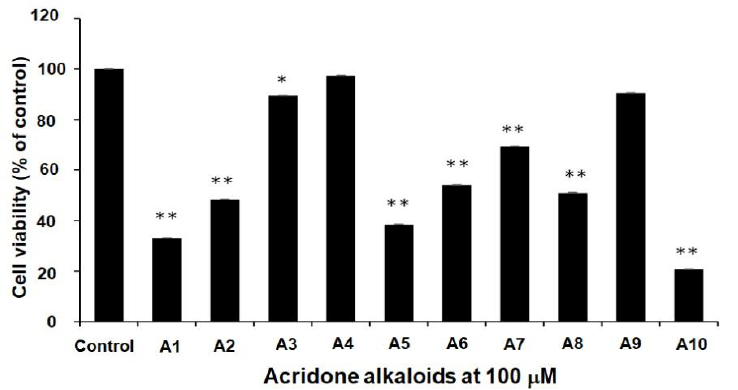
Figure 2. The cytotoxicity effect of acridone alkaloids N-methylatalaphylline (A1), atalaphylline (A2), N-methylatalaphyllinine (A3), atalaphyllinine (A4), N-methylcycloatalaphylline A (A5), citrusinine II (A6), citrusinine I (A7), glycosparvarine (A8), citruscridone (A9), and buxifoliadine E (A10)) on LNCaP cell line. Data are the means ± SD of at least three independent experiments; * p < 0.05, ** p < 0.01 by One-way ANOVA.